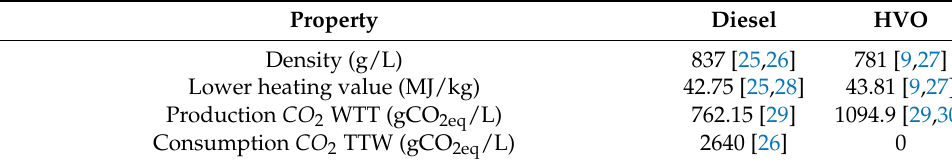
Figure 4. ( A ) Diesel and HVO ICE brake thermal efficiency comparison: map modified for HVO fuel with slightly greater efficiency at higher loads. ( B ) ICE—generator combined efficiency map with the optimal power line to be followed for minimal fuel consumption (diesel and HVO). Table 3. Fuel properties considered for diesel and